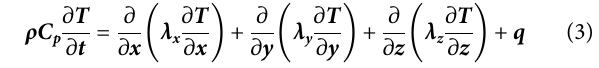
TABLE 1 | Parameters of lithium-ion battery cells Parameters Value (property)